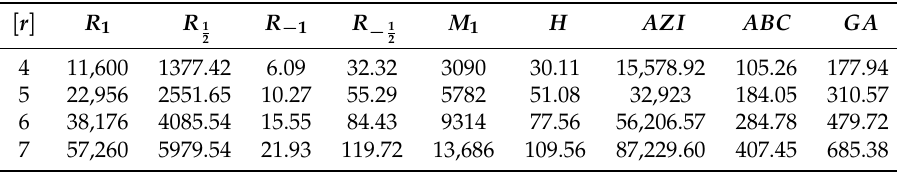
Table 7. Numerical computation of all indices for RHDN 3 ( r ) .